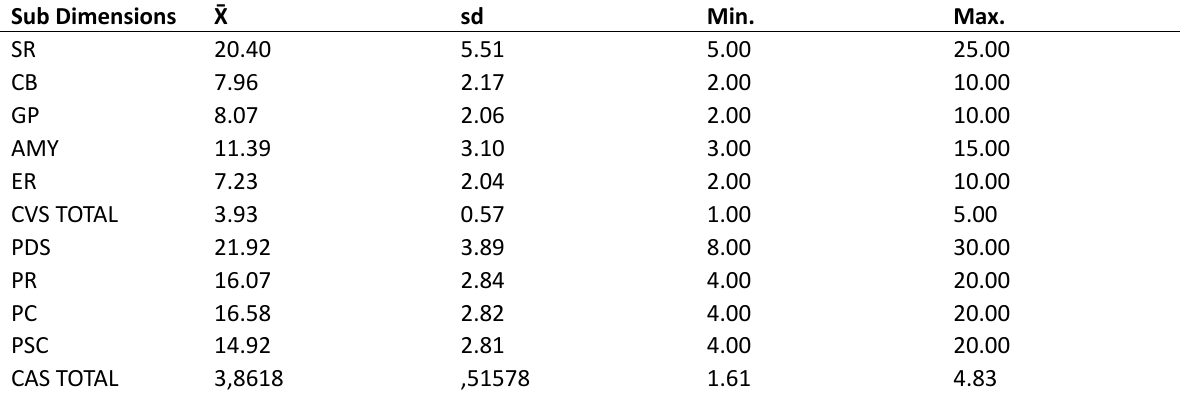
Table 2. Descriptive statistics of teachers’ CVS and CAS